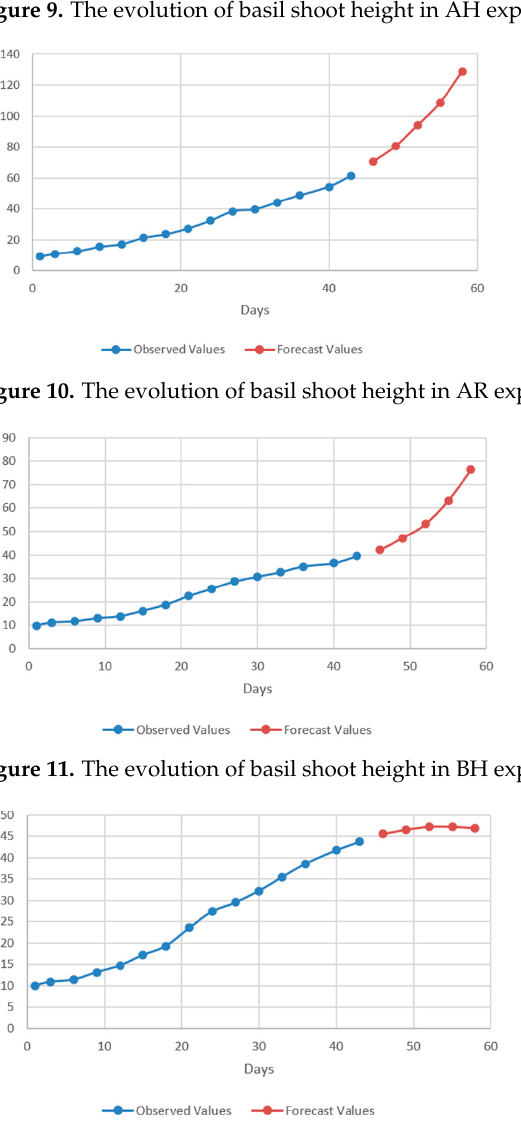
Figure 12. The evolution of basil shoot height in BR experimental variant.